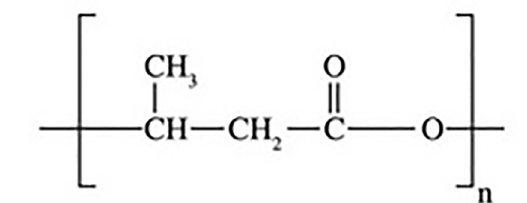
Figure 1. Poly(hydroxybutyrate) chemical structure 3 .